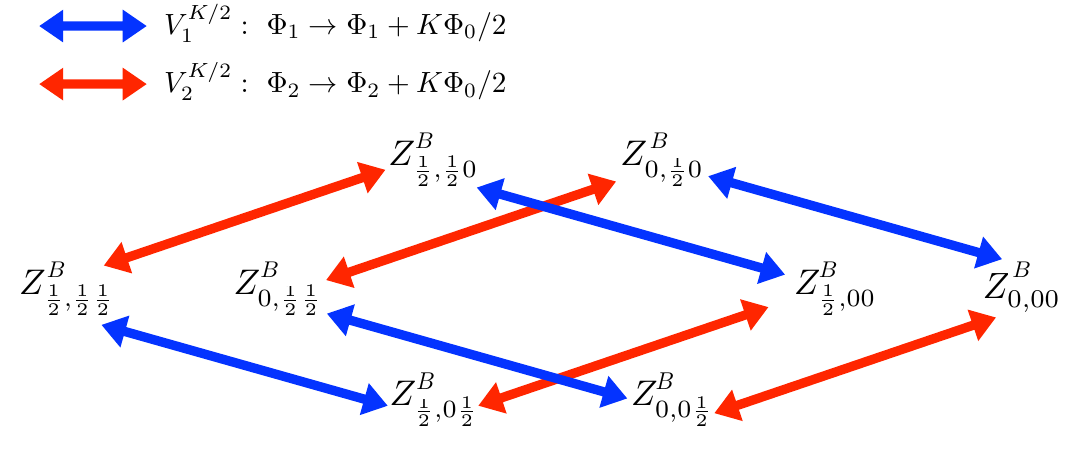
Figure 9 . V K= 2 and V K= 2 (cid:13)ux transformations on the bosonic partition functions Z B 1 2